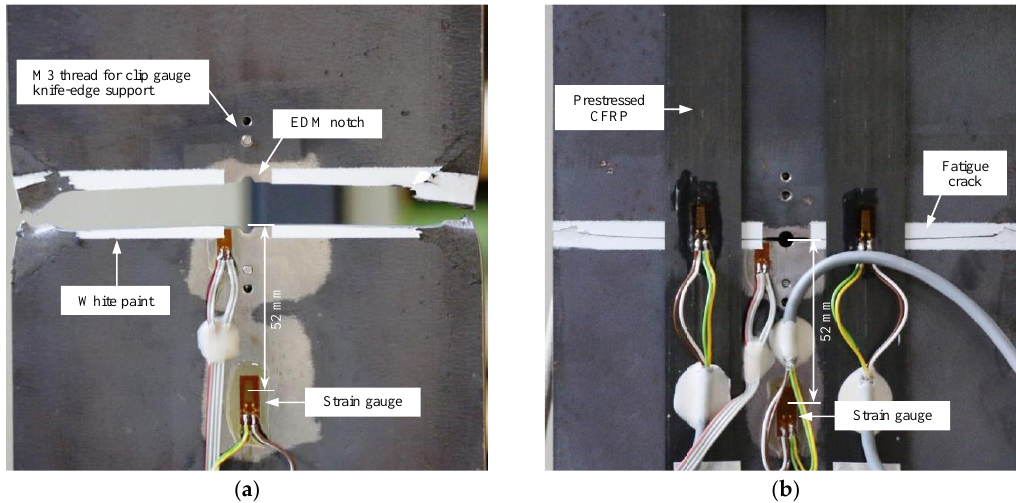
Figure 10. Arrangement of strain gauges and fatigue failure in ( a ) reference specimen; and ( b ) PUR specimen.